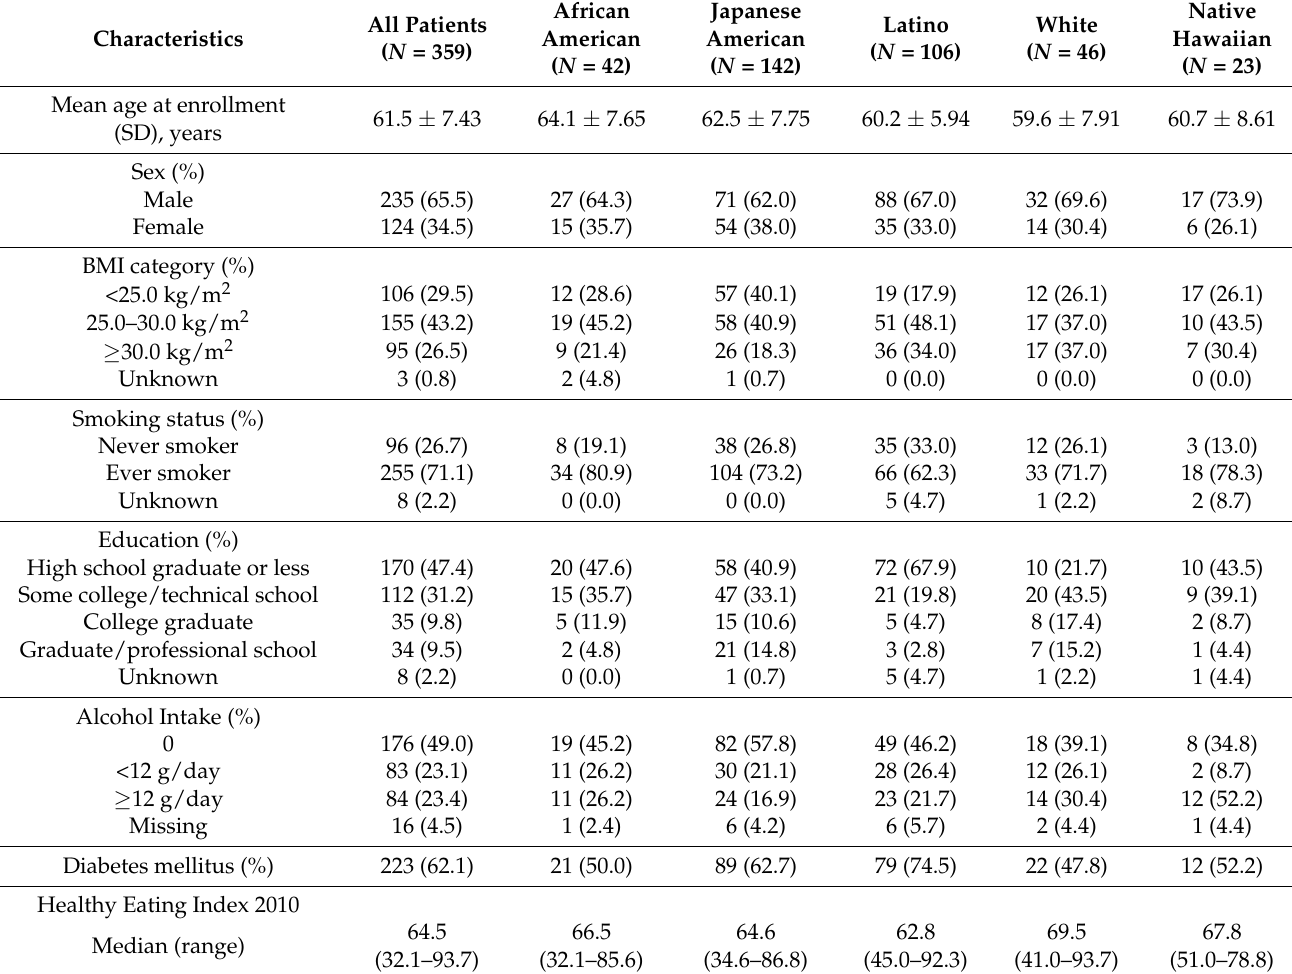
Table 1. Baseline characteristics of HCC in the Multiethnic Cohort by